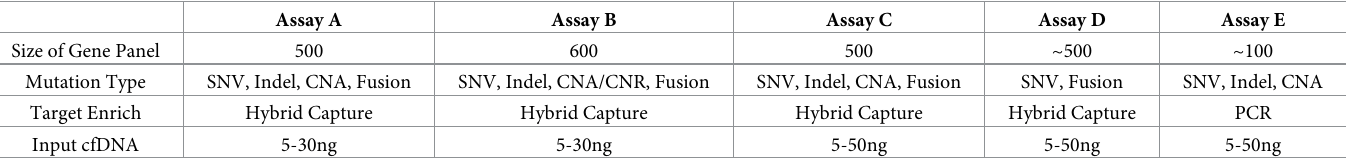
Table 1. Assay specifications from the